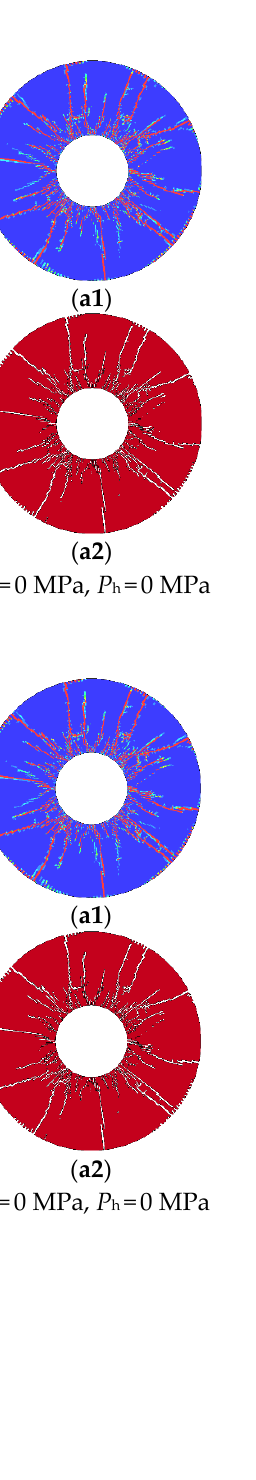
Figure 14. Case 3: ( a1 , b1 , c1 , d1 ) damage distribution in rock; ( a2 , b2 , c2 , d2 ) crack pattern.